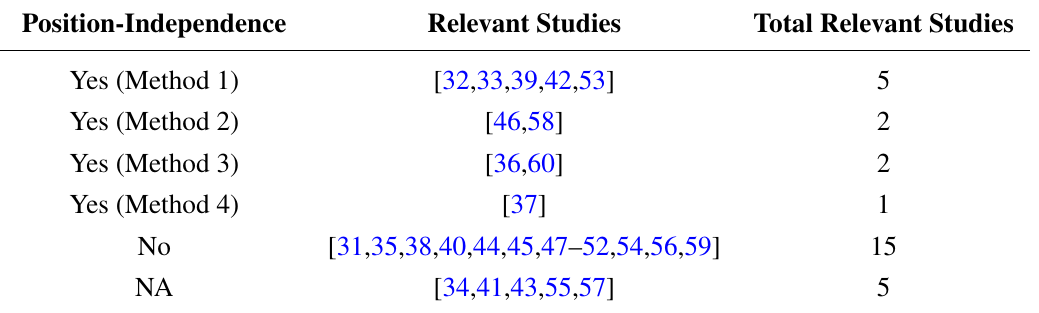
Table 12. Position-independent activity